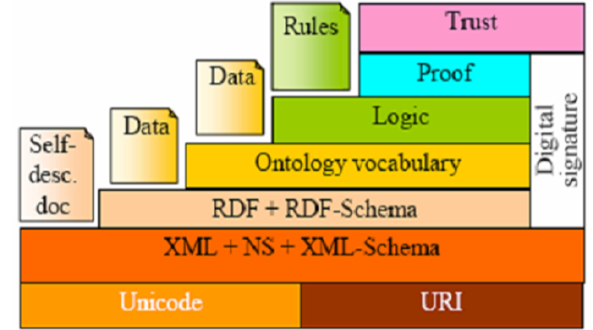
Figure 2. Layers of the semantic web.